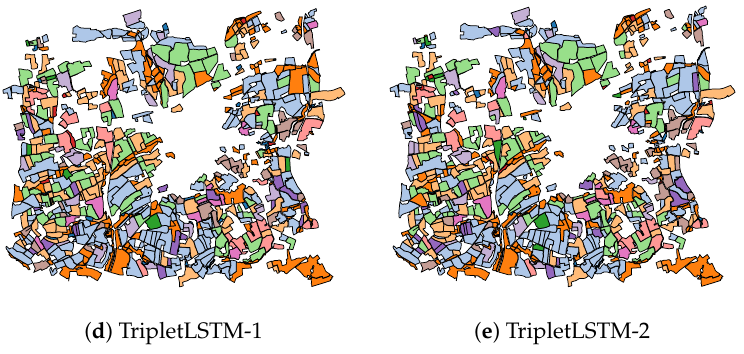
Figure 11. Classification maps of a subset of FRH04 (Figure 4) for RNN-based approaches: rapeseed, barley, vegetables, temp. meadows, protein crops, perm. meadows, cereals, orchards, miscellaneous, fallow, fodder, corn, wheat.